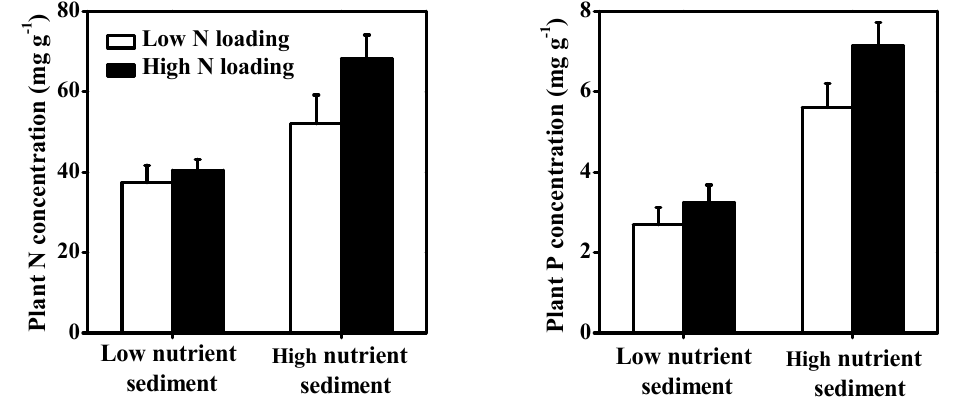
Figure 4. Plant N and P of V. natans grown in two nutrient sediments (low and high nutrient sediment) and with two levels of nitrogen loading (low and high N loading). Blank column represents low N loading; black column represents high N loading. Values are mean ± SD, n = 4 and the bars show standard deviation.